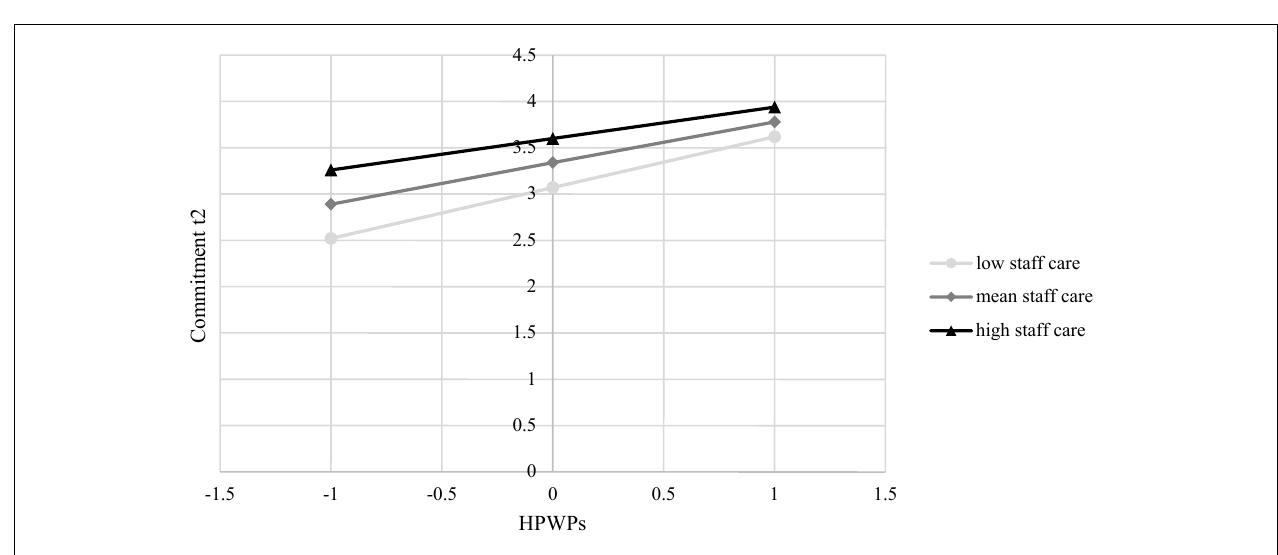
FIGURE 1 | The conditional effect of HPWPs on employees’ engagement at t2 probed at –1SD, mean, and + 1SD for staff care.